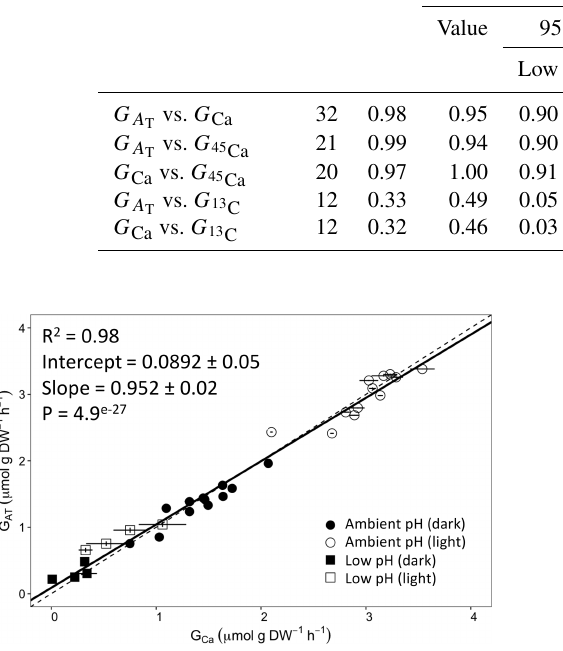
Figure 2. Calcification rates estimated based on the alkalinity anomaly technique ( G A ) as a function of calcification rates esti- T mated based on the calcium anomaly technique ( G Ca ). The dashed line represents the 1 : 1 relationship while the full line represents the model II regression relationship. Horizontal error bars represent standard errors (SE) associated with the estimation of G Ca . Vertical error bars representing SE associated with the estimation of G A are too small to be visible. The corresponding dataset can be found in Table S1.